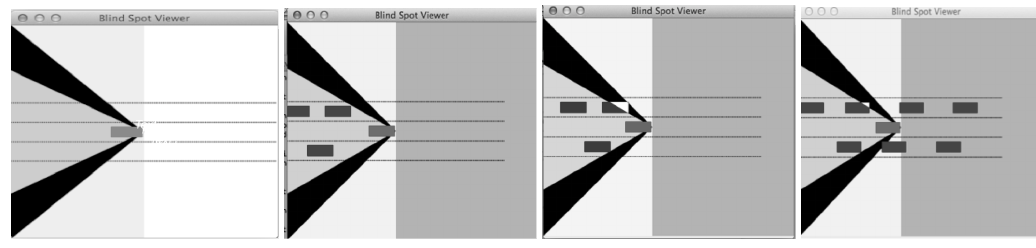
Figure 1. A sequence of screenshots from the simulator, illustrating a car moving in the middle lane of the